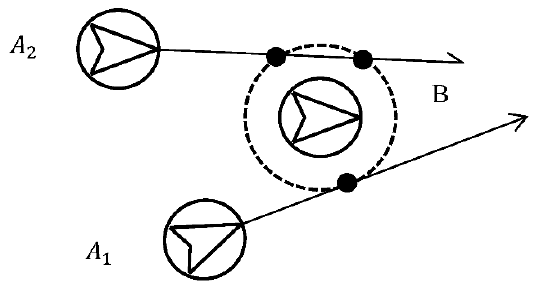
Figure 9. Sketch of collision detection.